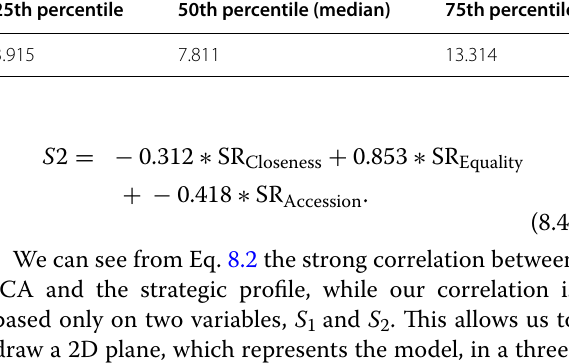
Table 4 Percentiles of the iCA relative absolute error distribution 25th percentile 50th percentile